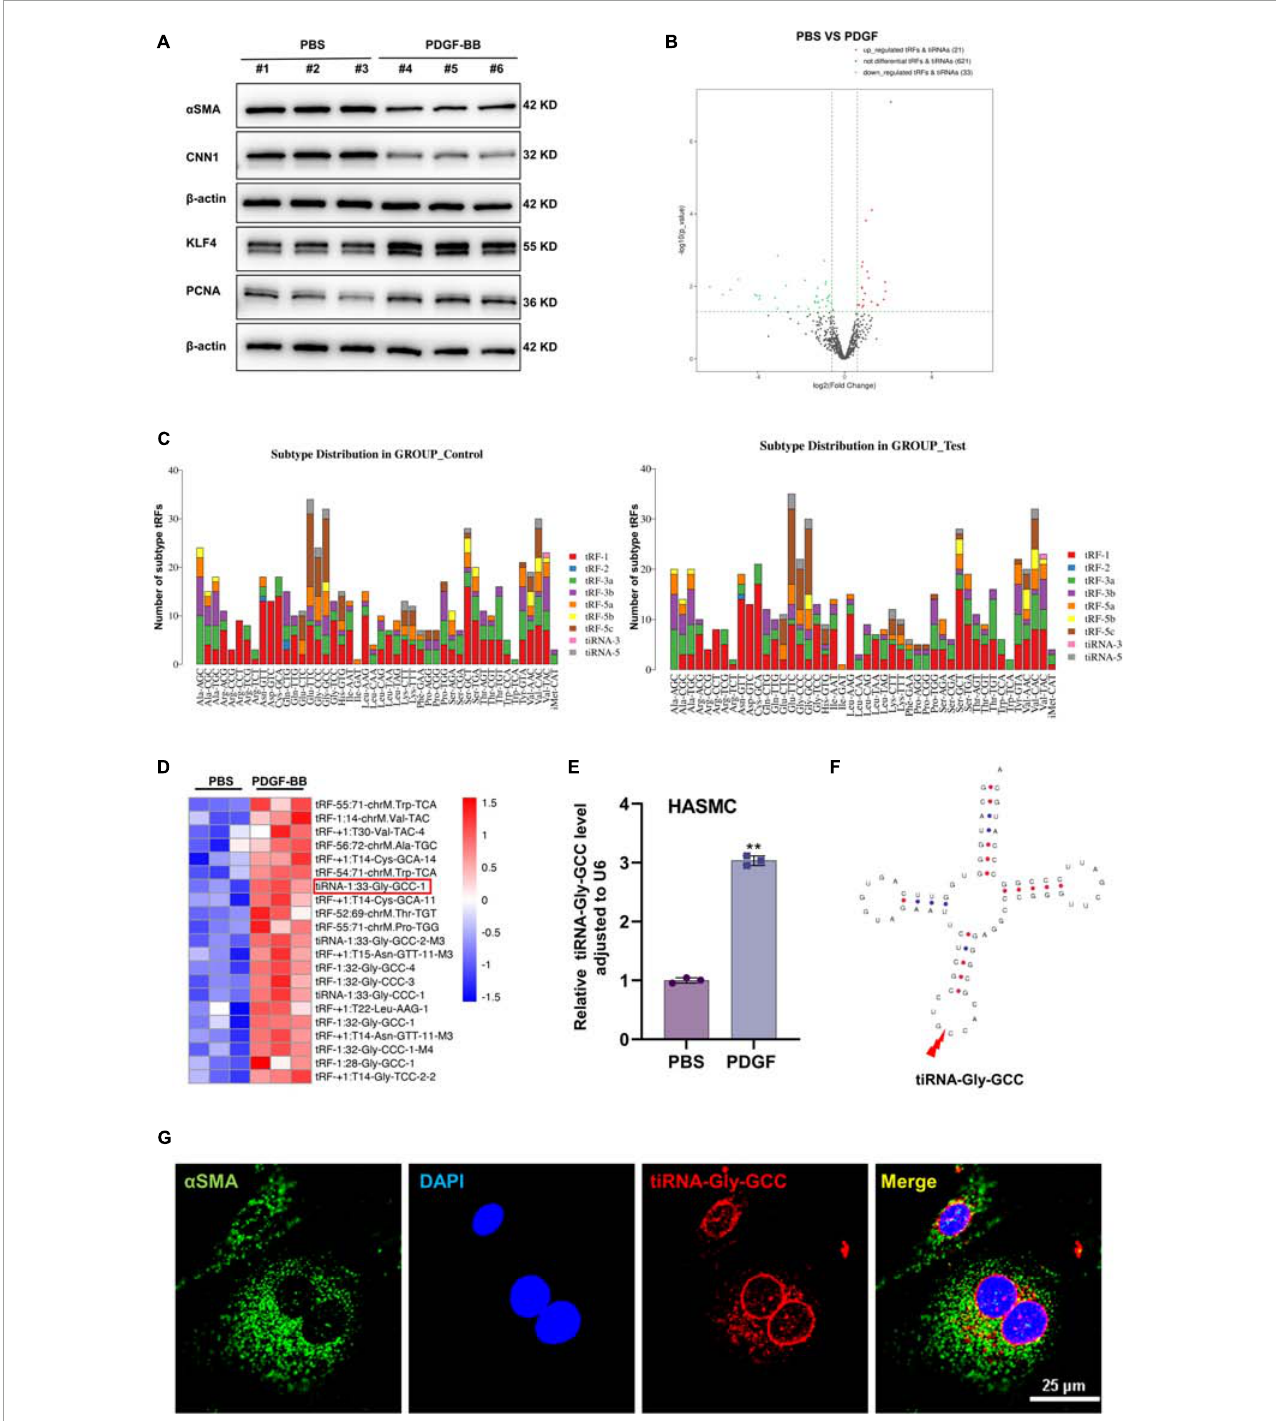
FIGURE1 Characteristics of tRF profiles during human aortic smooth muscle cells (HASMCs) phenotypic switching in vitro . (A) Western blot analysis showing VSMC-specific proteins α -smooth muscle actin ( α -SMA), calponin 1 (CNN1), synthetic protein Krueppel-like factor 4 (KLF4) and the cell proliferation marker, proliferating cell nuclear antigen (PCNA). Data were normalized to β -actin in HASMCs stimulated with platelet-derived growth factor-BB (PDGF-BB) (50 ng/ml). (B) Volcano plot showing differential expression profiles of tRFs in contractile (PBS) and synthetic (PDGF-BB) HASMCs, criteria for significant differences: | log2 (fold change) | > 1 and p < 0.05. (C) Stacked plot for the number of tRFs derived from the same tRNA: the X -axis and Y -axis represent the tRNA names and the number of tRFs derived from this class of tRNA, respectively. tRFs are separated subtypes by their sites and length. (D) Heatmap of tRFs differentially expressed in contractile (PBS) and synthetic (PDGF-BB) HASMCs. (E) Quantitative real-time PCR (qRT-PCR) confirmed that the expression of tiRNA-Gly-GCC was increased in HASMCs stimulated with PDGF-BB (50 ng/ml) compared with PBS, normalized to U6. Data are presented as the mean ± SD. n = 3, **p < 0.01. (F) Structure of tRNA-Gly-GCC and the cleavage site of tiRNA-Gly-GCC. (G) RNA-fluorescence in situ hybridization (RNA-FISH) and cellular immunofluorescence staining confirmed that tiRNA-Gly-GCC (red, cy3 labeled) was partially colocalized with α -SMA (green, 488-labeled) in the cytoplasm of HASMCs, and 4 (cid:48) ,6-diamidino-2-phenylindole (DAPI) (blue, labeled the nucleus). Scale bar, 25 µ